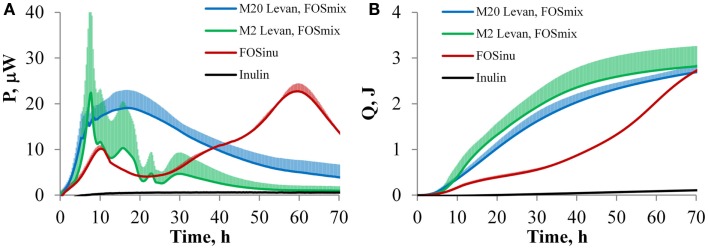
The curves of power (A) and accumulated heat (B) with SD during the growth of B. thetaiotaomicron DSM 2079 in the defined media M2 and M20 (2 and 20 amino acid added, respectively). Blue line: two replicates with each substrate, i.e., fructose, sucrose, levan, and FOSmix in the M20 medium are grouped together. Green line: two replicates with each substrate, i.e., fructose, sucrose, levan, and FOSmix in the M20 medium are grouped together. Red line: two replicates with FOSinu in the M20 medium.